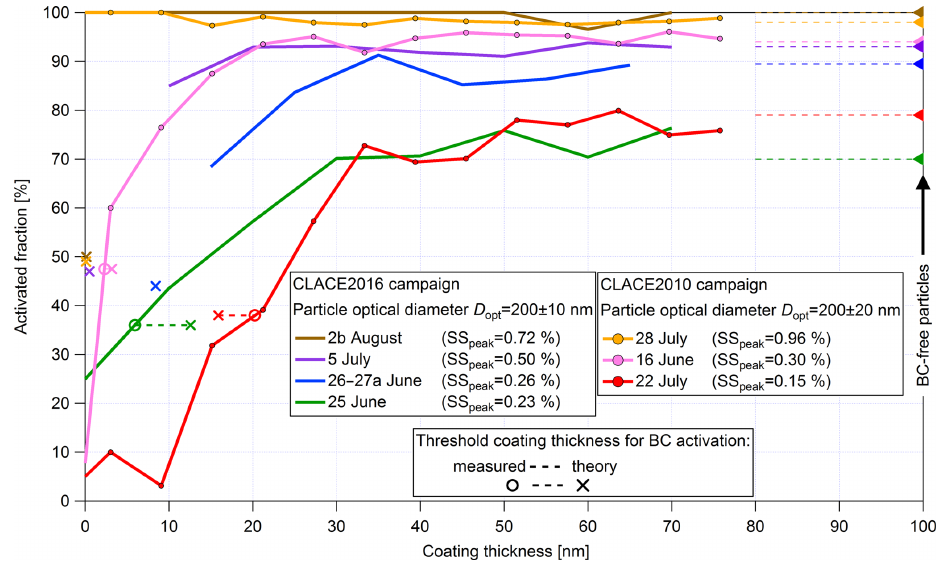
Figure 12. Activated fractions as a function of coating thickness for BC-containing particles with an optical diameter of 200nm during four stable cloud periods of the CLACE2016 campaign and three periods of the CLACE2010 campaign. Triangles accompanied by horizontal dashed lines correspond to the activated fraction of 200nm BC-free particles, derived from Fig. 2 (four example figures shown). The triangles are plotted at 100nm coating thickness because this corresponds to 200nm optical diameter if no BC core is present (BC-free particle). Dashed lines attached to activated fraction lines indicate the difference between experimentally observed (open circles) and theoretically predicted (crosses) coating thicknesses required for 200nm BC-containing particles to reach activation up to half of the activation